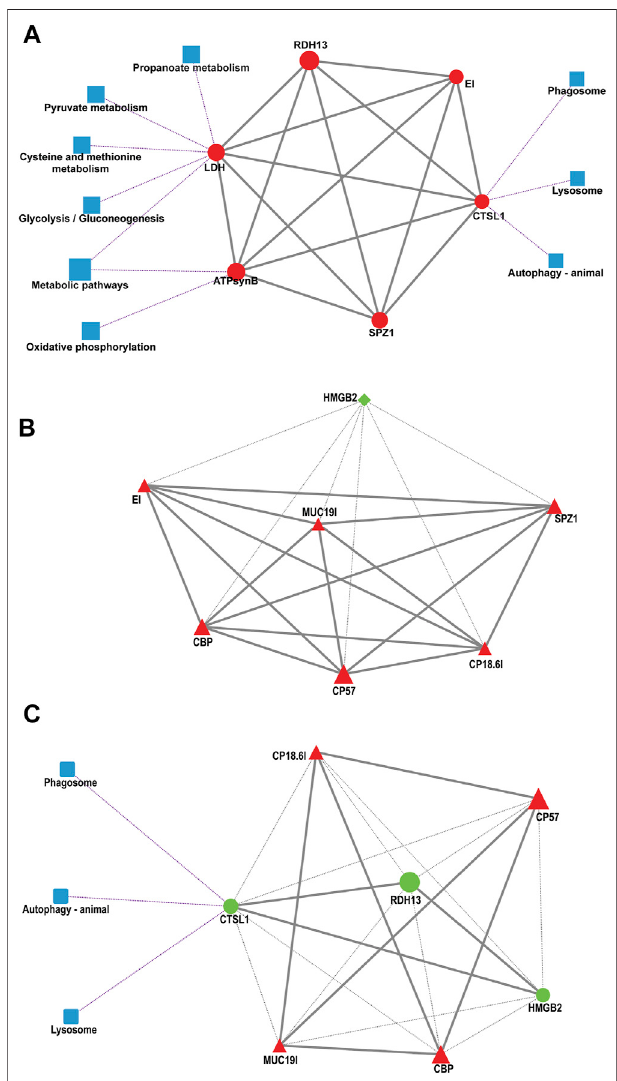
FIGURE7| Protein – proteininteraction(PPI)networksofDEGsvalidated byqPCRintheS10vs. S13comparison (A) ,S10vs.S16comparison (B) and S13 vs. S16 comparison (C) . The square represents the pathway that containing genes. The diamond represents the S10 group, the circle represents the S13 group, and the triangle represents the S16 group. The shape of the graph is determined by the unigene RPKM values, where red represents upregulation, green represents downregulation, and blue represents the pathway. The solid line represents a positive correlation, the gray dashed line represents a negative correlation, and the purple dashed line indicates the relationship between the genes and the pathways they are involved in.